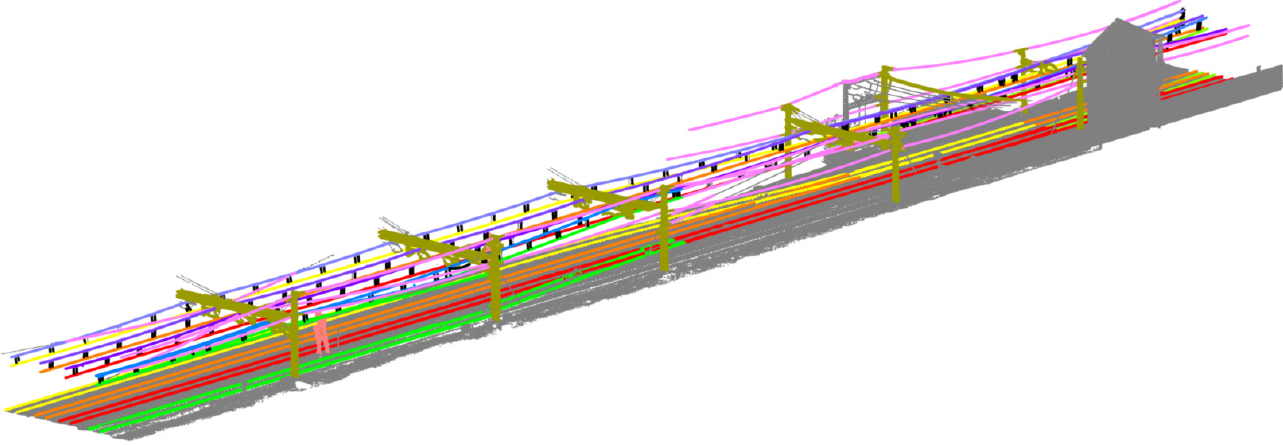
Figure A5. Four railway tracks segmentation: masts are represented in gold colour. Each contact wire has a different colour (yellow, orange, red, and green), matched by its correspondent rail. Each catenary has also a random colour. Other wires are coloured in pink, droppers in black, and traffic lights in orange.